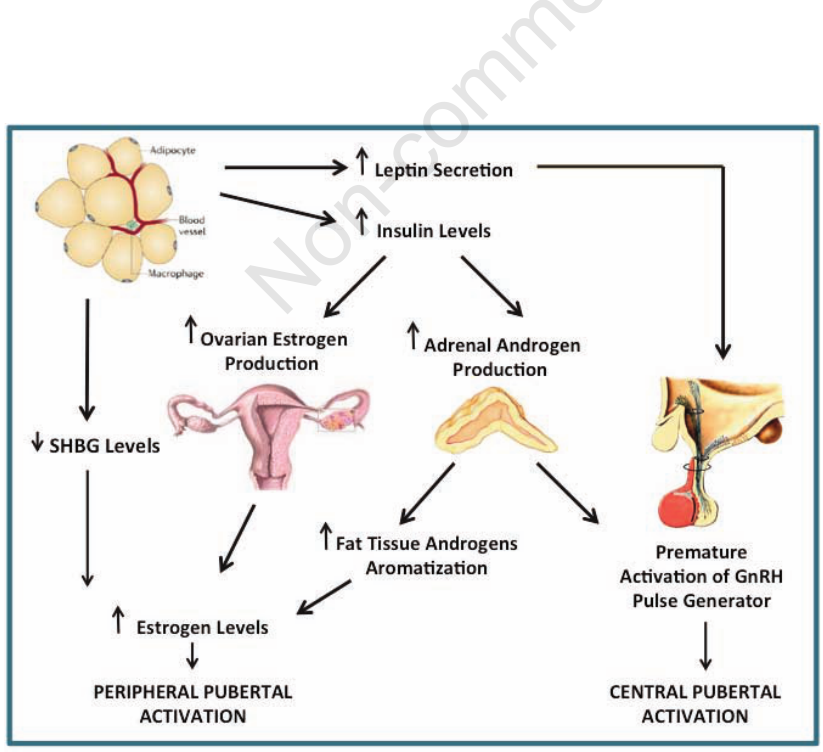
Figure 2. Pathophysiology of earlier pubertal onset in obese